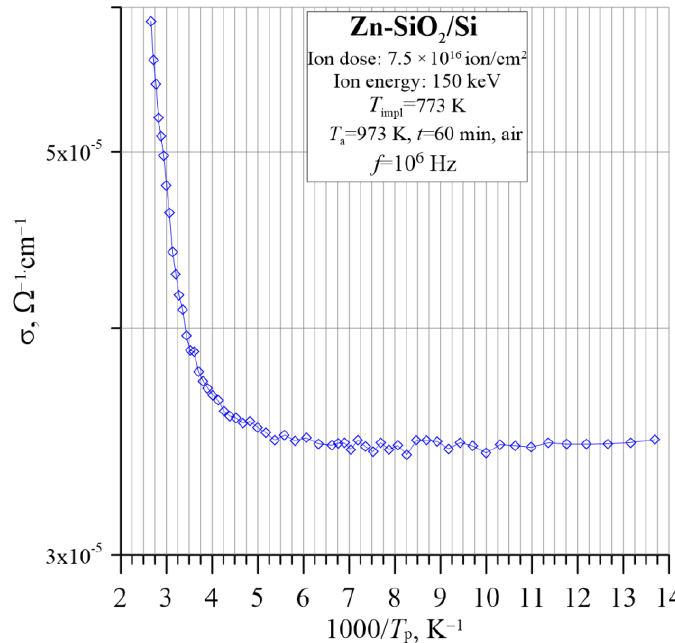
Figure 11. The Arrhenius dependence of the conductivity σ for the Zn-SiO 2 /Si nanocomposite prepared under “hot” implantation conditions (150 keV, 7.5 × 10 16 ion/cm 2 , T impl = 773 K) after annealing for frequency f = 10 6